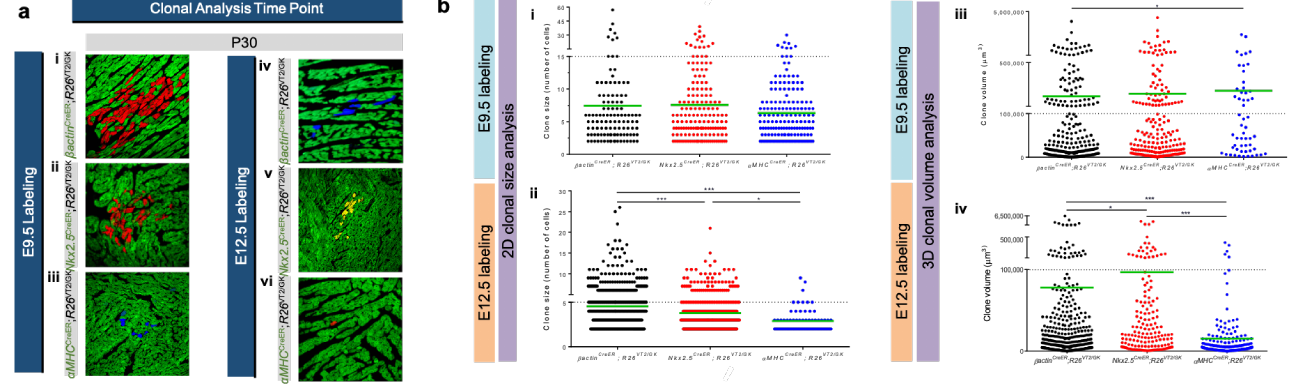
Figure 5. Clonal Expansion in the in vivo developing heart: ( a ) confocal microscope images of labeled clones in (i,iv) β actin CreER ;R26 VT2/GK , (ii,v) Nkx2.5 CreER ;R26 VT2/GK and (iii,vi) α MHC CreER ;R26 VT2/GK mouse hearts at P30. In this study, 4-OHT administration and subsequent cell-labeling were completed at (i–iii) E9.5 or (iv–vi) E12.5. Clonal clusters were more evident in (i,ii,iv,v) cardiac progenitor cells compared with (iii,vi) cardiomyocytes [38]; ( b ) analysis of (i,ii) labeled clone sizes and (iii,iv) labeled clone volumes at E9.5 and E12.5 in β actin CreER ;R26 VT2/GK , Nkx2.5 CreER ;R26 VT2/GK , and α MHC CreER ;R26 VT2/GK mouse hearts, respectively. (i,iii) similar clone sizes and volumes were observed in cardiac progenitors and cardiomyocytes at E9.5. (ii,iv) Decreased clone volume in cardiomyocytes compared to cardiac progenitor cells at E12.5, with (iv) α MHC-expressing cardiomyocyte clone volume showing the most drastic decrease